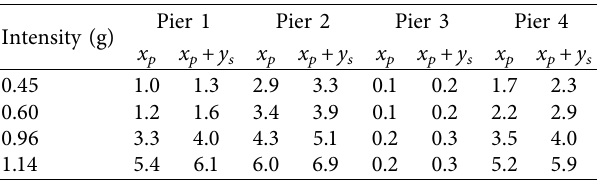
Table 5: Maximum relative displacement (unit: mm) between each pier and continuous girder under diferent experimental earth- quake intensities (in x direction).